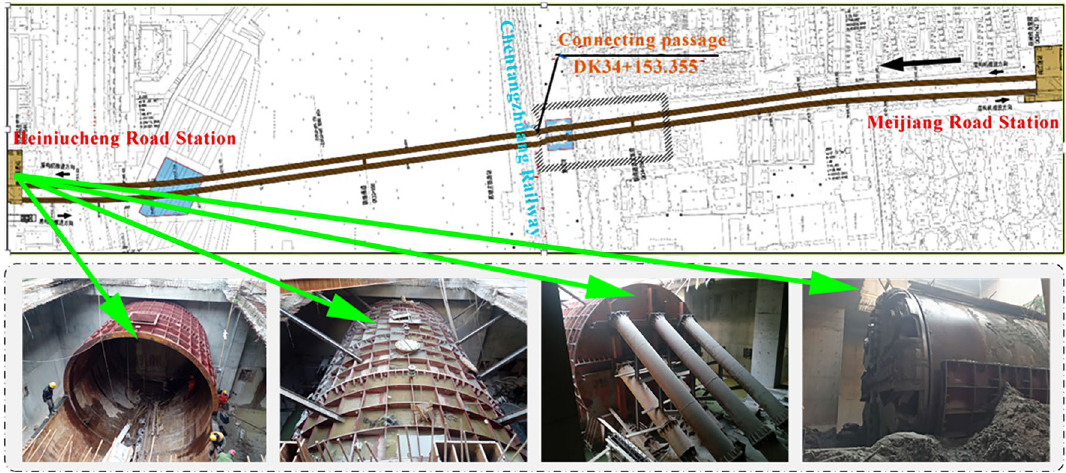
Figure 6. Diagram of the section of Heiniucheng Road Station to Meijiang Road Station of Tianjin Metro Line